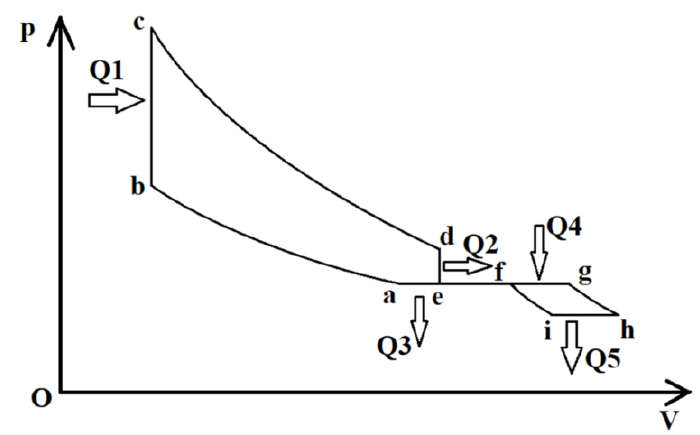
Figure 6. Theoretical cycle of the DSC-VCR with turbocharging.